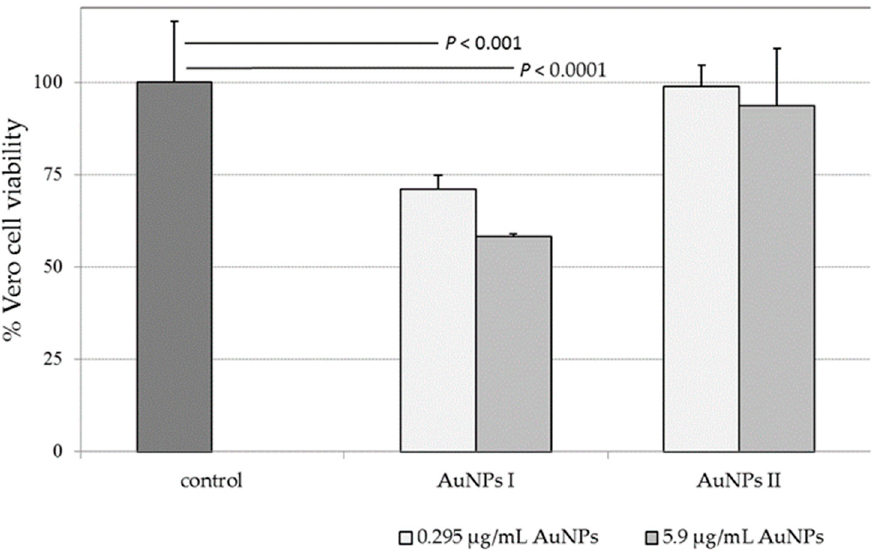
Figure 2. Cytotoxicity of AuNPs in Vero cells. Number of viable cells to the untreated cell control (%) after incubation for 48 h. AuNPs of approximate diameters of 10 nm (AuNPs I) and 16 nm (AuNPs II) were used at concentrations of 0.295 and 5.9 µ g/mL, respectively. The cell viability was measured using an MTT assay. The data are shown as means ± SD of three experiments performed six times. P, Student’s t -test.